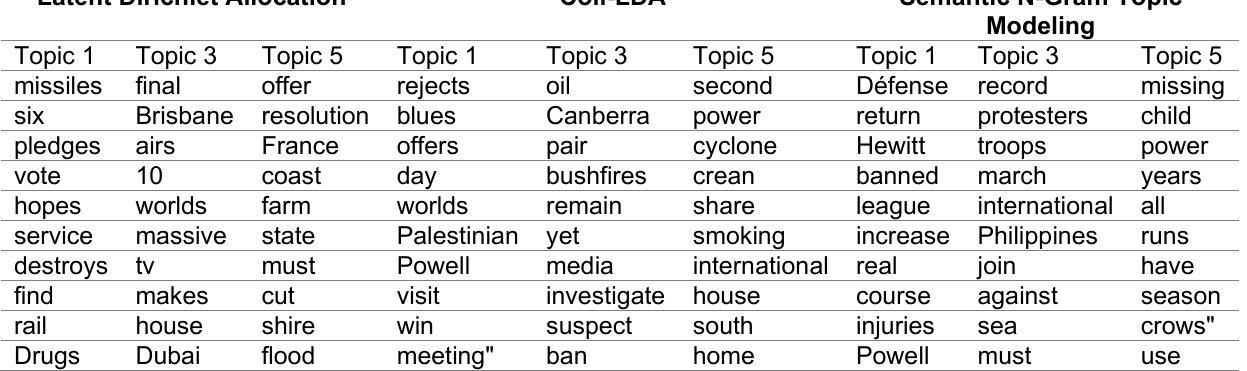
Table 3. Top Ten terms for three topic modelling techniques in ABC News Headlines